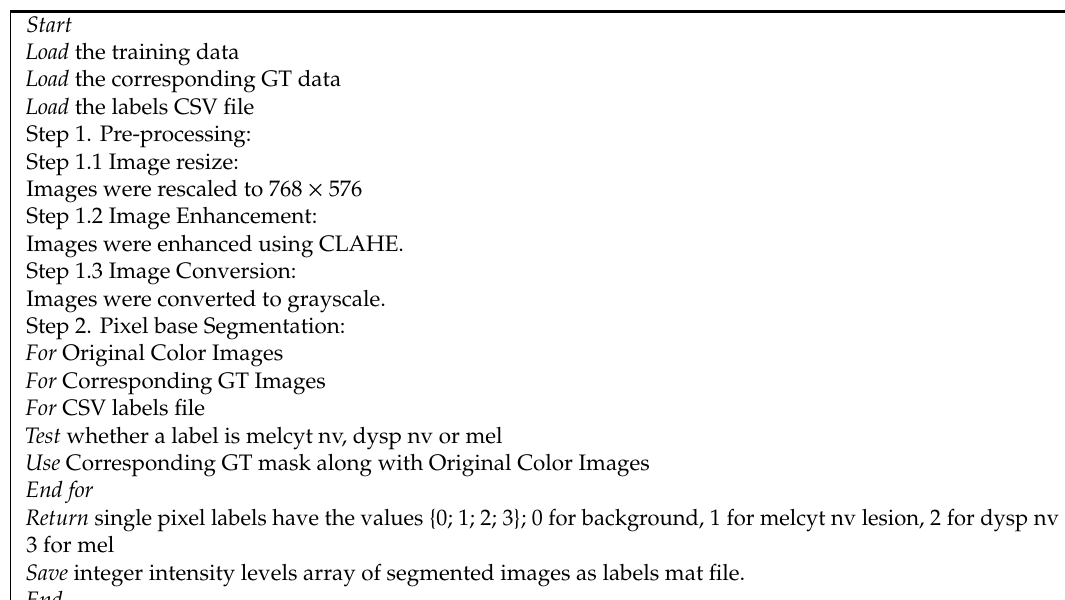
Table 2. The pseudo-code for staging melanocytic